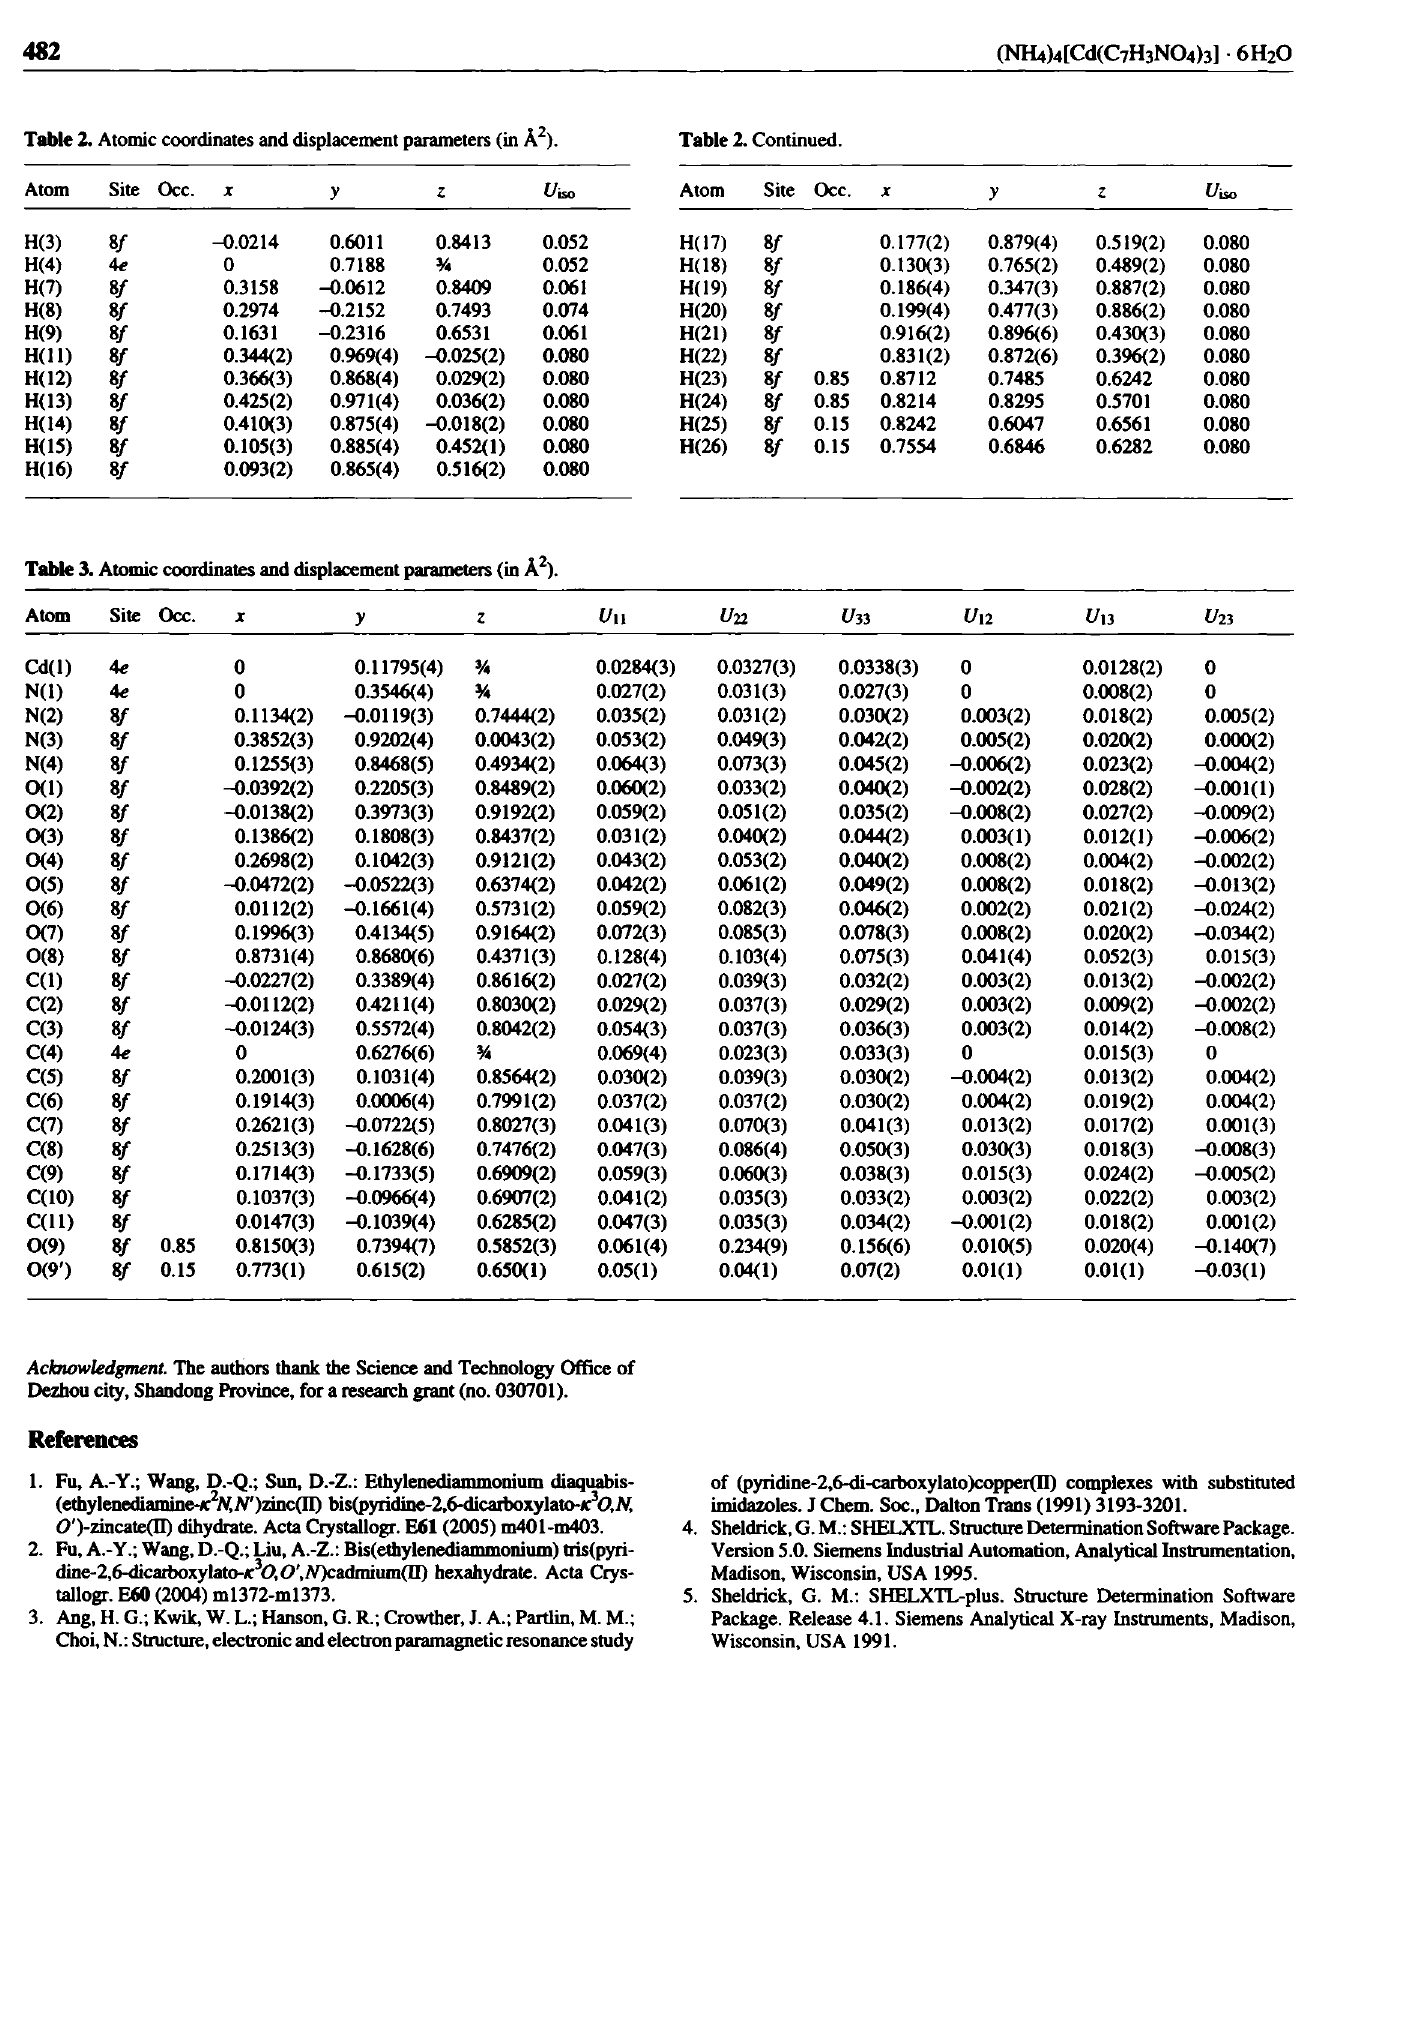
Table 3. Atomic coordinates and displacement parameters (in A 2